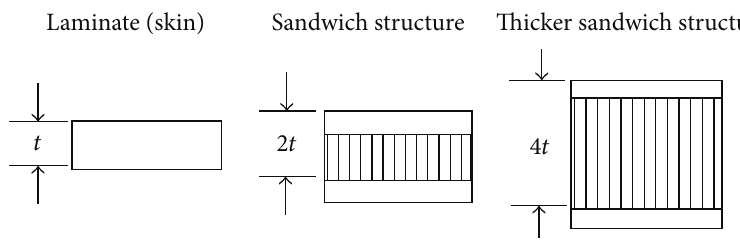
Figure 10: Global structure of different types of laminates